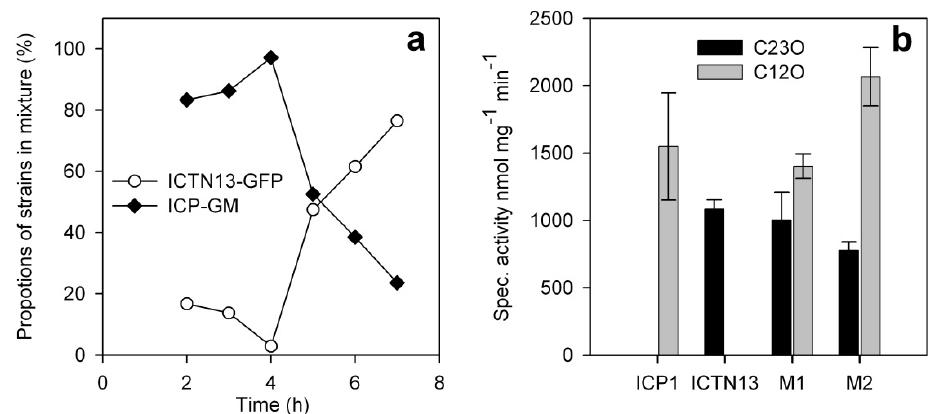
Figure 9. Proportions of the strains ICP1-GM (gentamicin-resistant strain ICP1) and ICTN13-GFP (GFP-labelled strain ICTN13) in the mixed cultures during the growth on 1.3 mM phenol at 30 °C ( a ), and specific activities of the key catabolic enzymes, C12O and C23O, in the crude extracts of the cells derived from the cultures either containing single strains or the mixture of these strains (M) sampled from the middle exponential (ICP1, ICTN13, M1 (5 h)) and early stationary growth phases (M2 (7 h)) ( b ). The growth curve of bacteria and the phenol utilization patterns were the same as presented in Figure 8b. The proportions of cells of both strains in the mixed cultures determined by the FACS analysis (Figure 9a) were taken into account in the calculation of the specific activities of the enzymes.